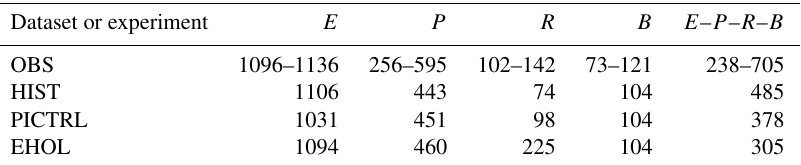
Table 1. The Mediterranean Sea freshwater budget, expressed as mmyr − 1 for the whole water area (about 2.5millionkm 2 ). E is evaporation; P is precipitation; R is river runoff; B is Black Sea discharge into the Mediterranean Sea. OBS is a summary from Sanchez-Gomez et al. (2011) for P , E and P – E , from Ludwig et al. (2009) for R , from Lacombe and Tchernia (1972), Stanev et al. (2000) and Kourafalou and Barbopoulos (2003) for B . River discharges in HIST are from the climatology of Ludwig et al., (2009). PICTRL uses the Nile of its pre- industrial (pre-damming) value (2930m 3 s − 1 ) annually (Rivdis database; Vorosmarty et al., 1998). River discharges in EHOL are deduced from the difference between EHOL and PICTRL.